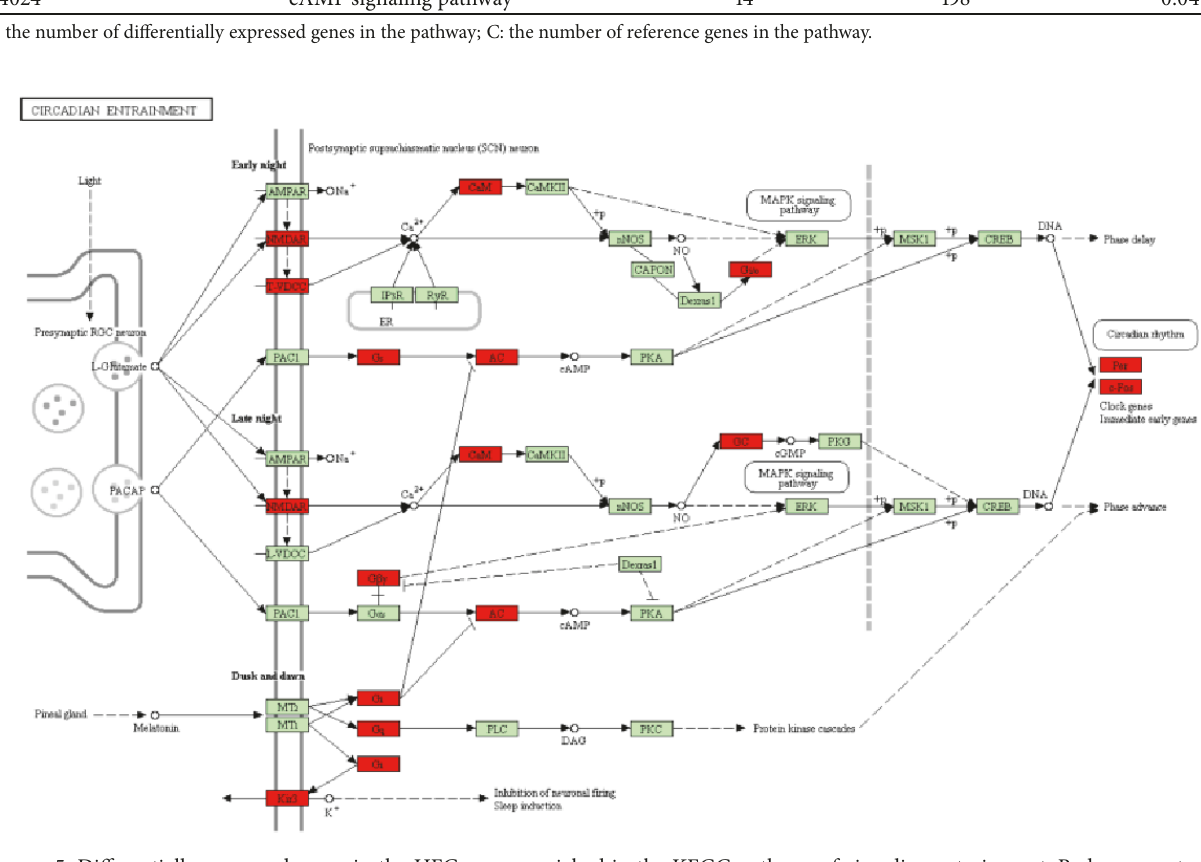
Figure 5: Differentially expressed genes in the HFG group enriched in the KEGG pathway of circadian entrainment. Red represents the different expression